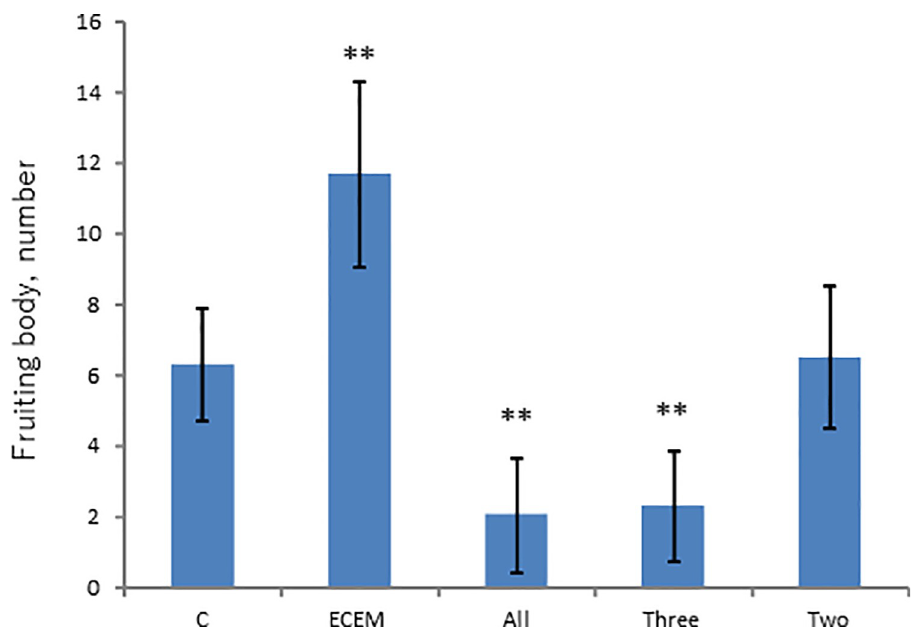
Fig 3. Assay of combinatorial mixture of fractions in Fig 2. C (Control without ECEM); ECEM (10% ECEM); All (All fractions combined); Three (Fr. 1, Fr. 2 and Fr. 4 are combined); Two (Fr. 3 and Fr. 5 are combined). �� : Significant difference in comparison to the Control by Steel test (p < 0.01).